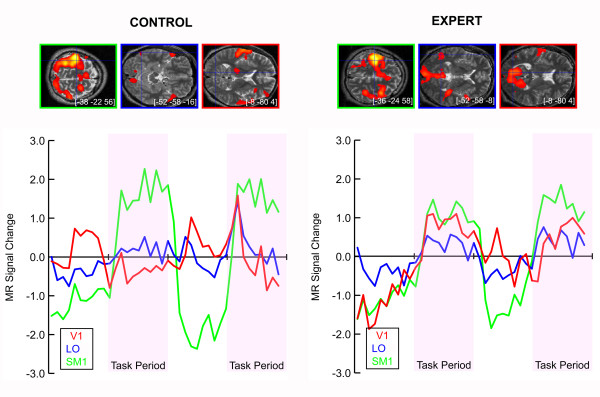
Individual analysis of the task-related activation in the left S1 (green), left LO (blue), and V1 (red). (Top) The foci with significant activation during Mah-Jong tactile discrimination by a non-expert (left) and an expert (right) were superimposed on the transaxial images of the T2-weighted high-resolution MRI of each subject. Blue lines indicate the projection of the yz and xz sections in standard stereotaxic space at the MNI coordinates indicated in each image. (Bottom) The time courses of the MR signal changes of each location (V1 in red, LO in blue, and SM1 in green) were plotted. The mean value of the time-course data of each plot was centered to zero.